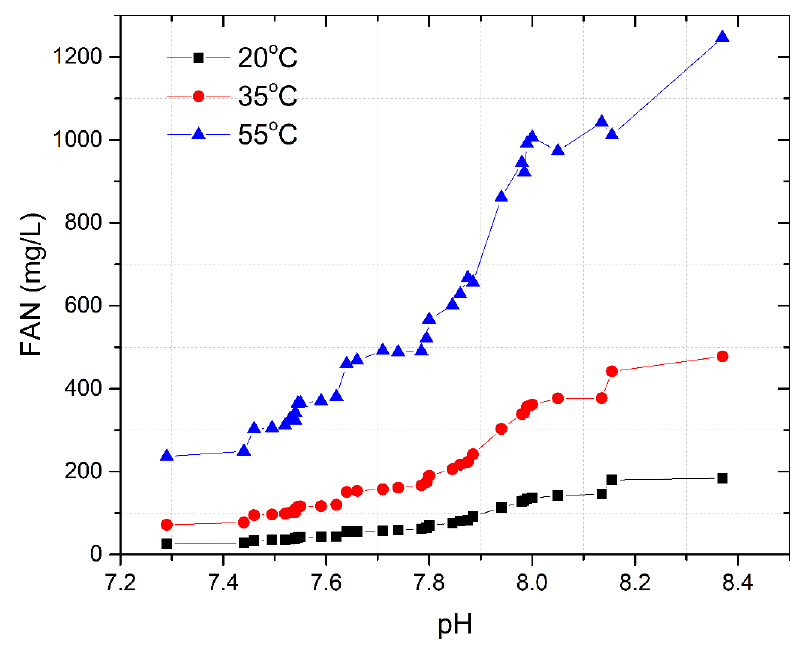
Figure 6. FAN at di ff erent temperatures under an operating pH Figure 6. FAN at different temperatures under an operating pH range.